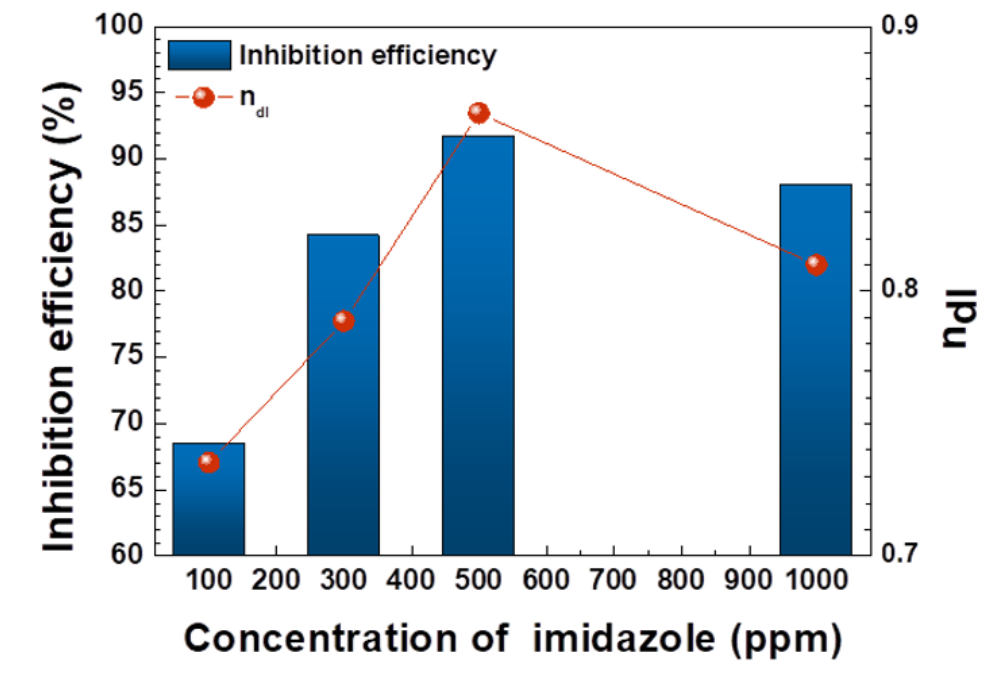
Figure 5. Inhibition efficiency (%) from potentiodynamic polarization test and value of n dl from EIS.